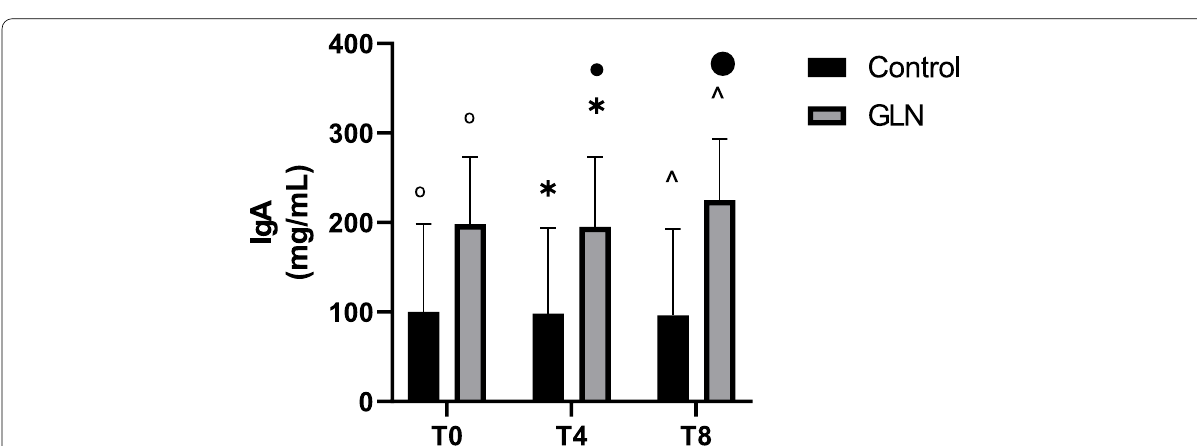
Fig. 1 IgA levels in control and glutamine (GLN) groups. Data are presented as mean control at T0 ( p < 0.05), at T4 ( p < 0.05), and at T8 ( p < 0.01); • indicates a significant difference ( p < 0.05) in the GLN group between T4 and